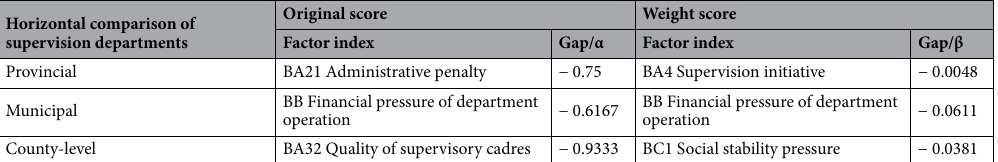
Table 16. Analysis of the shortcomings of the basic index scores of provincial, municipal and county-level supervisory departments (subsystem B)—horizontal comparison.